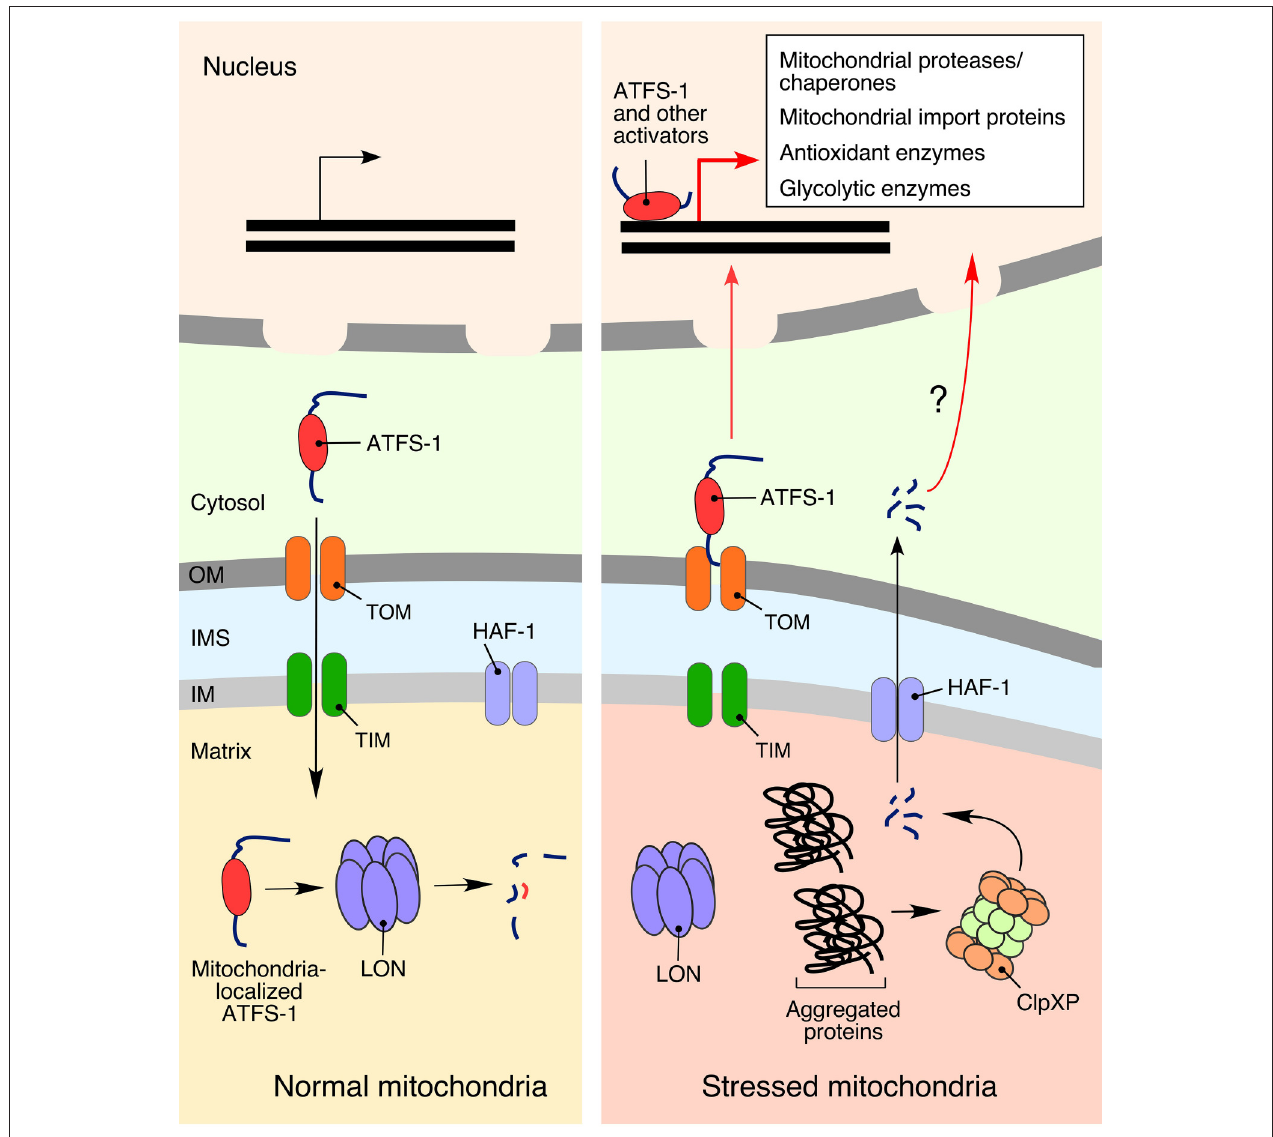
FIGURE 3 | The mitochondrial unfolded protein response (UPRmt). Activation of UPRmt in response to mitochondrial damage is best characterized in the roundworm Caenorhabditis elegans , where it is regulated by the activating transcription factor associated with stress 1 (ATFS-1). In the absence of stress stimuli, ATFS1 is transported to the mitochondria and degraded by LON protease (Nargund et al., 2012). Conditions of mitochondrial stress stall mitochondrial import of ATFS-1, allowing a fraction of the protein to translocate into the nucleus and promote expression of more than 400 mitochondrial homeostasis-related genes (Lin